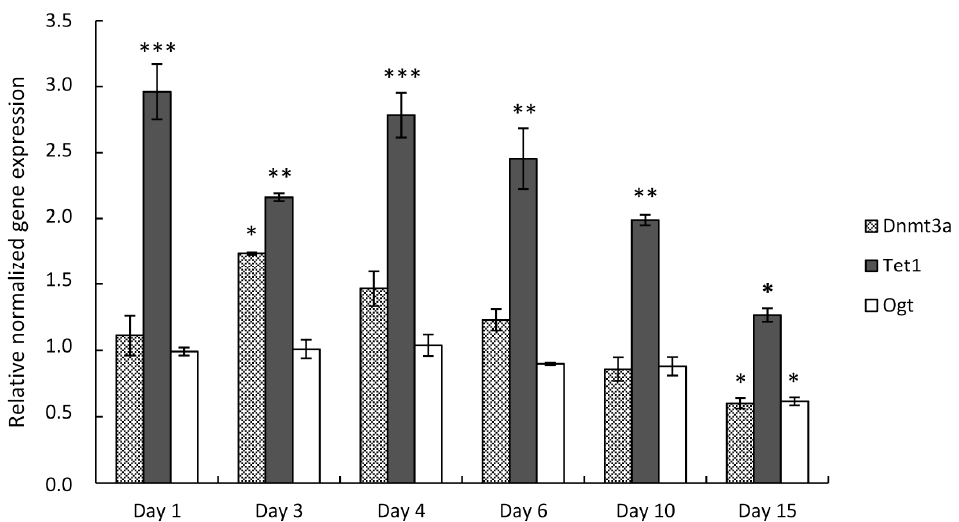
Figure 3. DNA methylation-specific marker gene expression in primary chondrifying micromass cul- tures on various days of culturing during in vitro cartilage formation as determined by RT-qPCR. Data are expressed as the mean ± SD relative to culturing day 0 and normalized against the reference gene Sdha . Statistically significant differences of gene expression levels between consecutive culturing days are indicated by asterisks as follows: * p < 0.05; ** p < 0.01; *** p < 0.001. Representative results out of 3 independent experiments showing similar trends of changes.